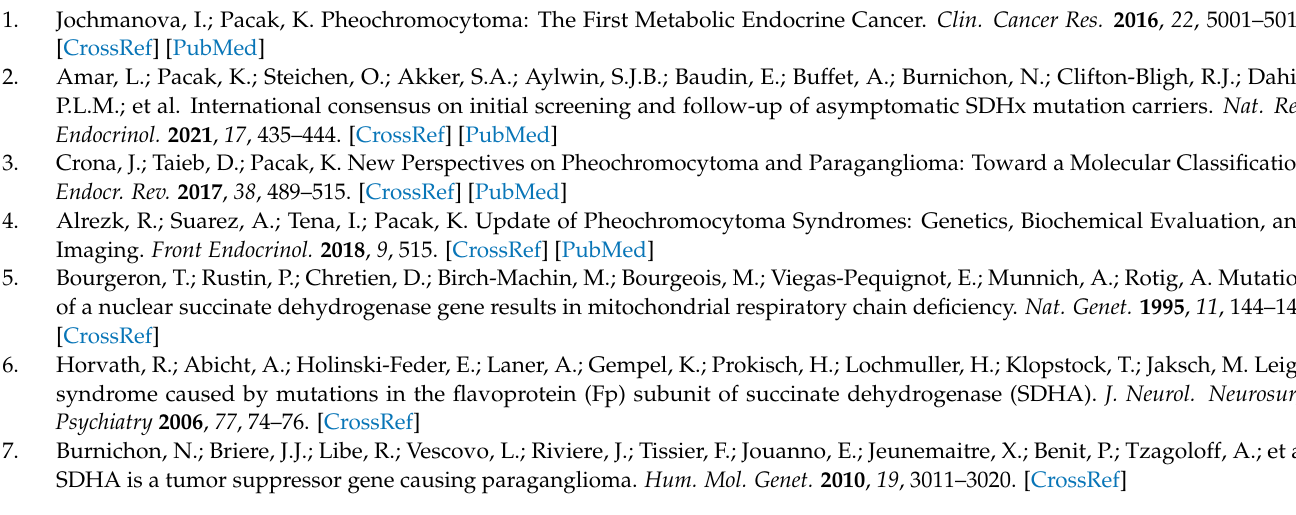
11 Patients; Figure S2: Contingency Tables for 7 Patient Subset. Contingency Tables compare lesions detected on 68 Ga-DOTATATE to the other imaging modalities for the Patients with SDHA -related